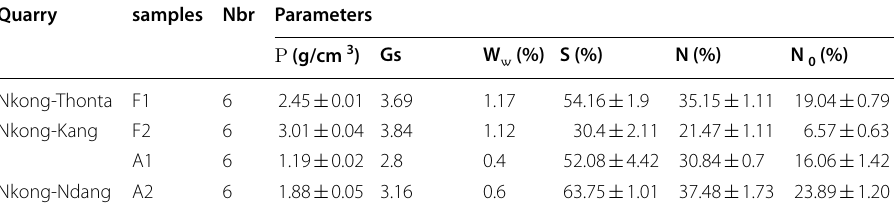
Table 3 Physical properties of the stone lateritic blocks of Bamendjou Quarry